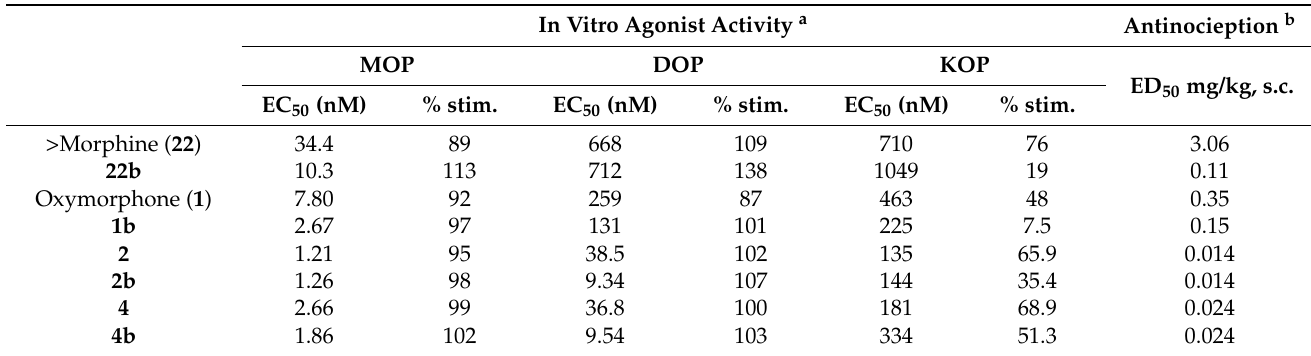
Table 9. In vitro agonist activities and antinociceptive of N -methylmorphinans 22 , 1 , 2 and 4 , and their N -phenethyl substituted analogues 22b , 1b , 2b and 4b